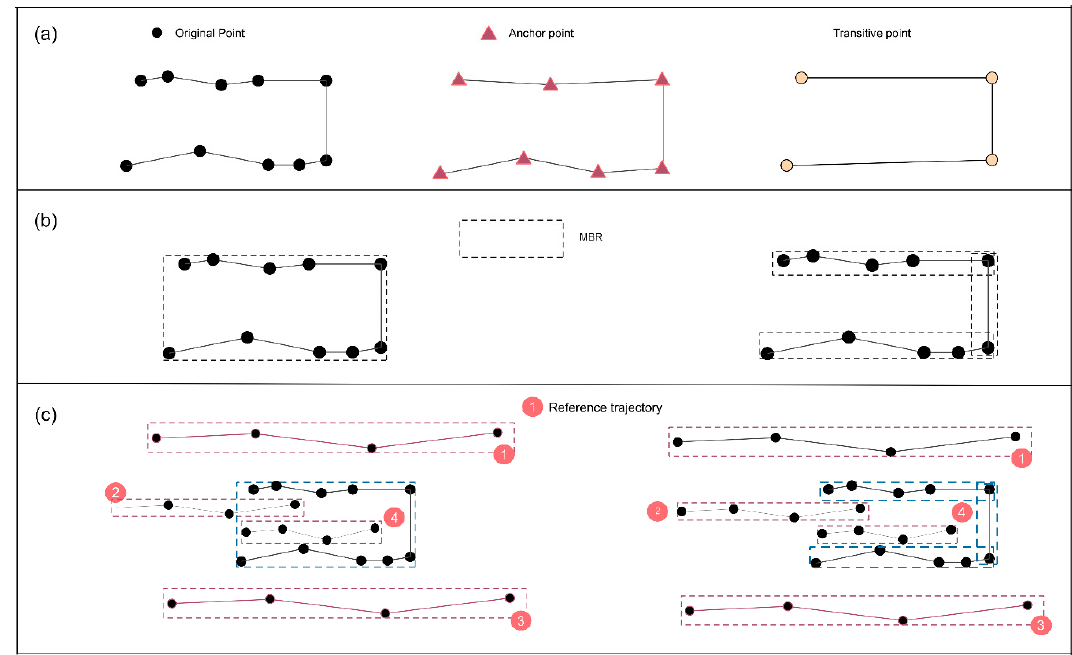
Figure 3. The process of producing progressive MBRs and filtering reference trajectories with MBRs: ( a ) line simplification and angular-based segmentation; ( b ) MBR creations; ( c ) intersection detection with different MBRs.